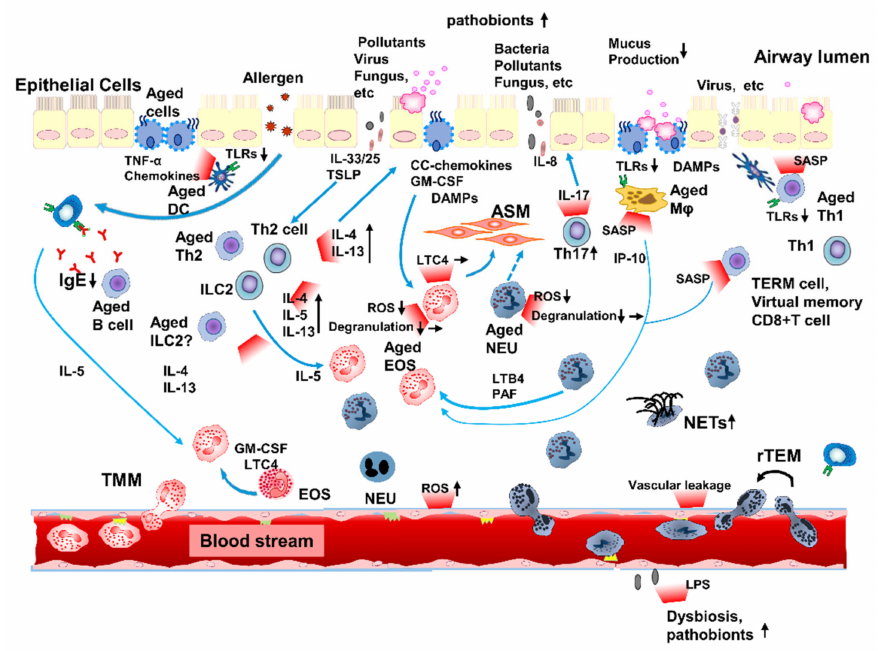
Figure 2. Conspectus of inflammaging in asthma in the elderly. Aged bronchial epithelial cells increase and deteriorate mucociliary function and mucoid production, resulting in increased suscep- tibility to infection and noxious pathogens. Immunosenescence leads to inflammaging progression accompanied with enhanced type-2 inflammation. Senescent phagocytes play a role by affecting pathogens and influencing the production of proinflammatory cytokines, chemokines, and SASP with the decline of TLRs. Senescent and exhausted T cells generate those mediators and SASP. Type-2 cytokines produced by Th2 cells and ILC2s increase in recognition of IL-33, IL-25, and TSLP, though the effect of aged Th2 cells remains to be elucidated. Th17 cells increase in elderly patients with asthma due to increase in IL-6 and TGF- β . Increase in IL-17 contributes to immune response in circulating neutrophils due to rTEM on distant vascular endothelium, the form of which is modified by dysbiosis, accompanied with mast cells in aged humans. Senescent neutrophils easily promote NETs. Neutrophils activated by IL-8 and LPS through the release of LTB4 and PAF can enhance the accumulation of eosinophils through TMM, which is enhanced in severe asthma. Accumulated eosinophils and neutrophils corporate to promote airway inflammation and remodeling, leading to a stronger decline in pulmonary function. Type-2 inflammation with inflammaging could lead to the progression of unstable asthma